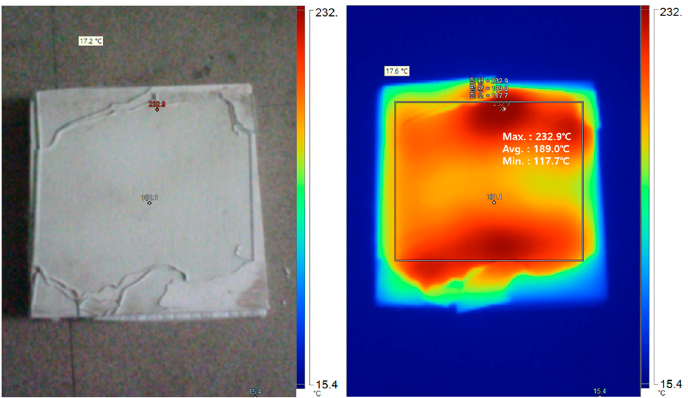
Figure 9. Experimental results obtained at a temperature of 200 °C and a heating rate of 8 °C/min. An image of the glass ( left ) and the temperature distribution ( right ).